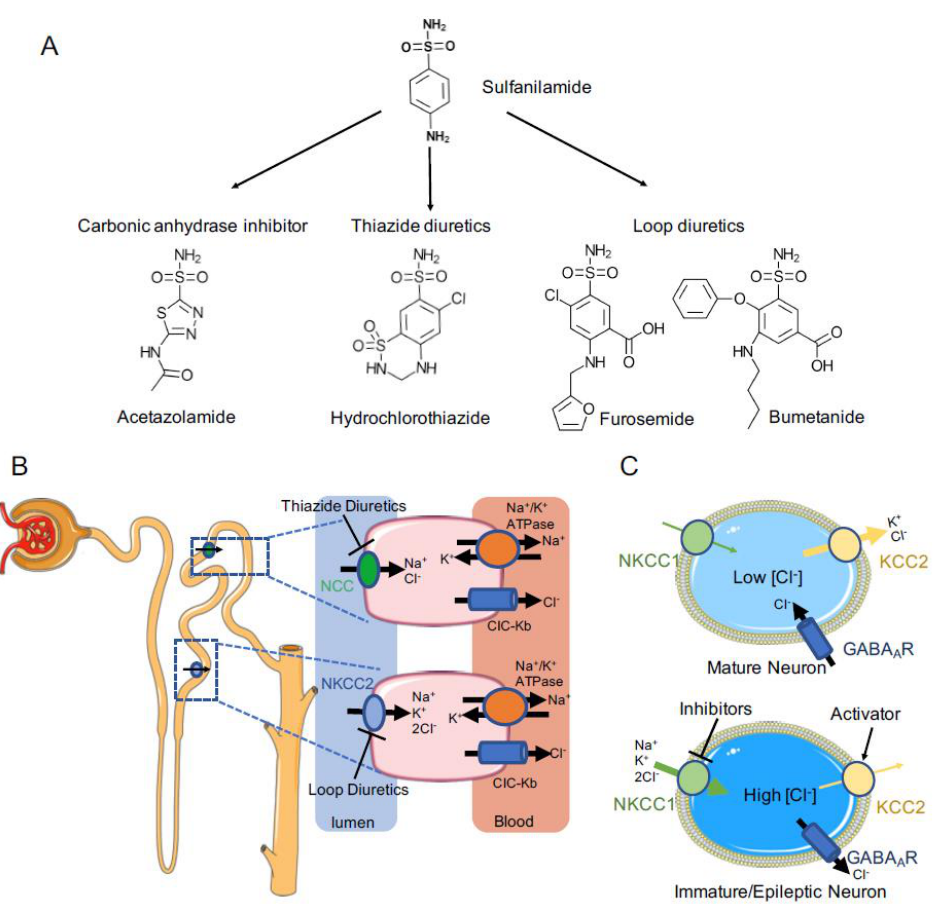
Figure 1. Cation − chloride cotransporters are the molecular targets of diuretic drugs in the kidney and regulate polarity of GABA response in nervous system. ( A ) Sulfanilamide inspired the development of three classes of diuretics. ( B ) Loop and thiazide diuretics inhibit NKCC2 − and NCC − mediated salt and water retention in the kidney, respectively. ( C ) NKCC1 and KCC2 function as the major Cl − loader and extruder in neuron, respectively. Their opposing actions are critical in setting [Cl − ] i in neurons and, consequently, the polarity of GABA